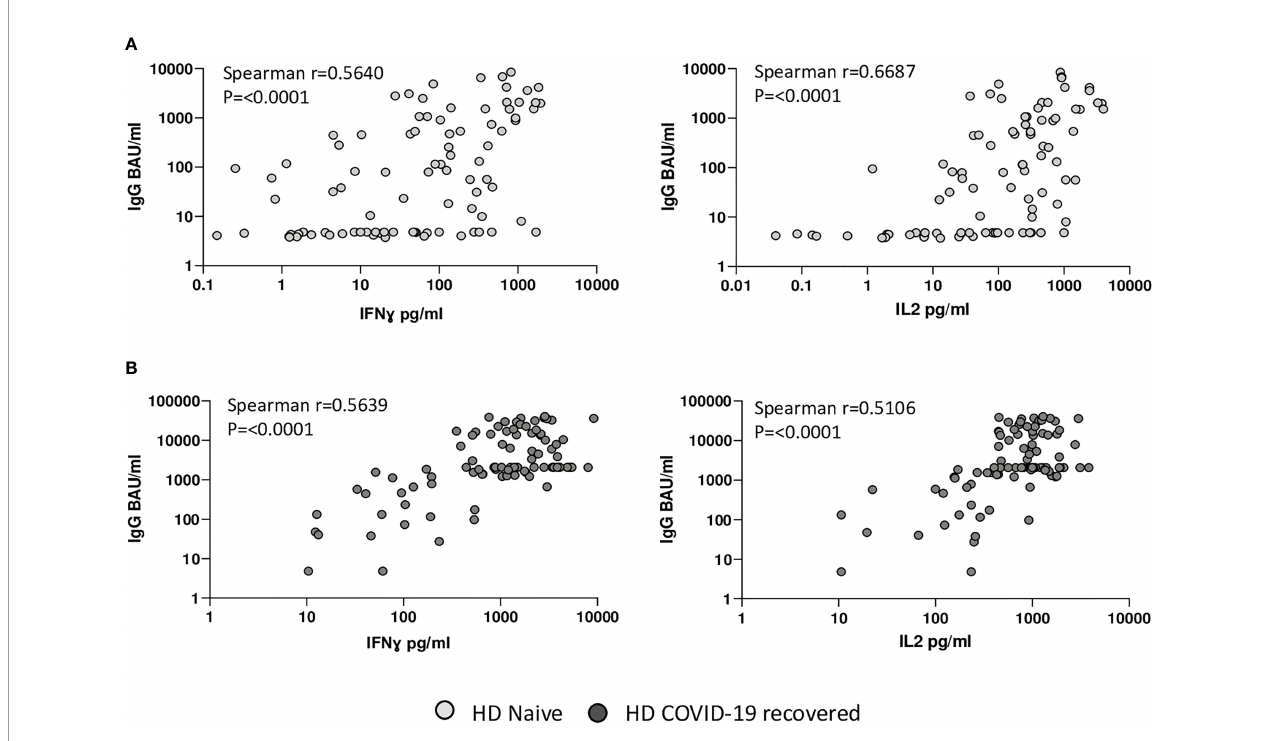
FIGURE 3 | Relationship between cellular and humoral immune response in naïve and COVID-19 recovered HD patients. (A) Correlation between IFN- ɣ and IL-2 levels and SARS-CoV-2 spike-speci fi c IgG serum levels in naïve HD patients. (B) Correlation between IFN- ɣ and IL-2 levels and of SARS-CoV-2 spike-speci fi c IgG serum levels in COVID-19 recovered HD patients. Figure shows all data points available from any time point for all